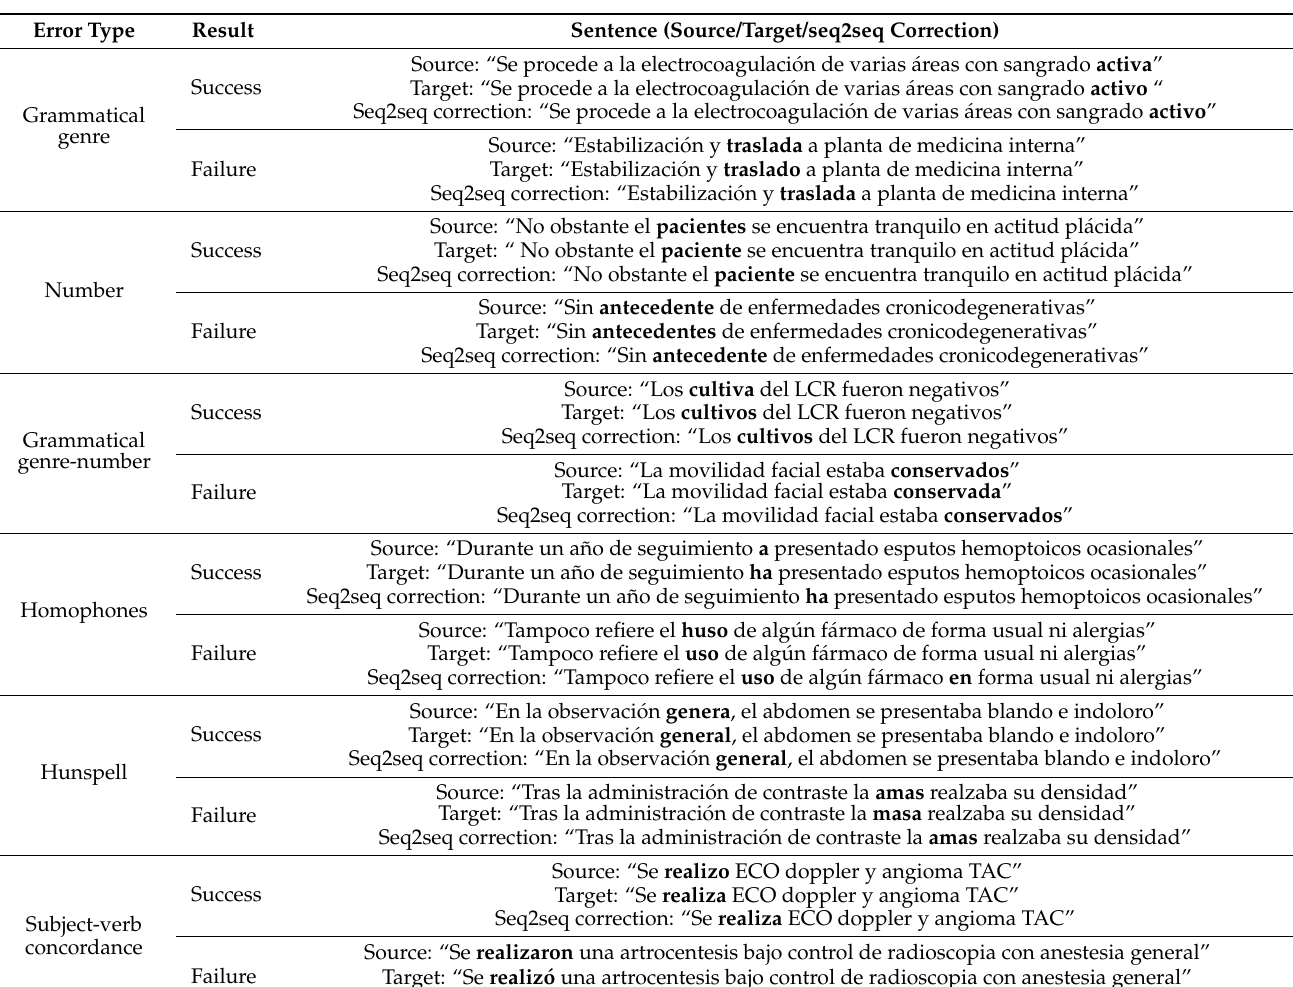
Table 7. Sample successful and failed corrections (in